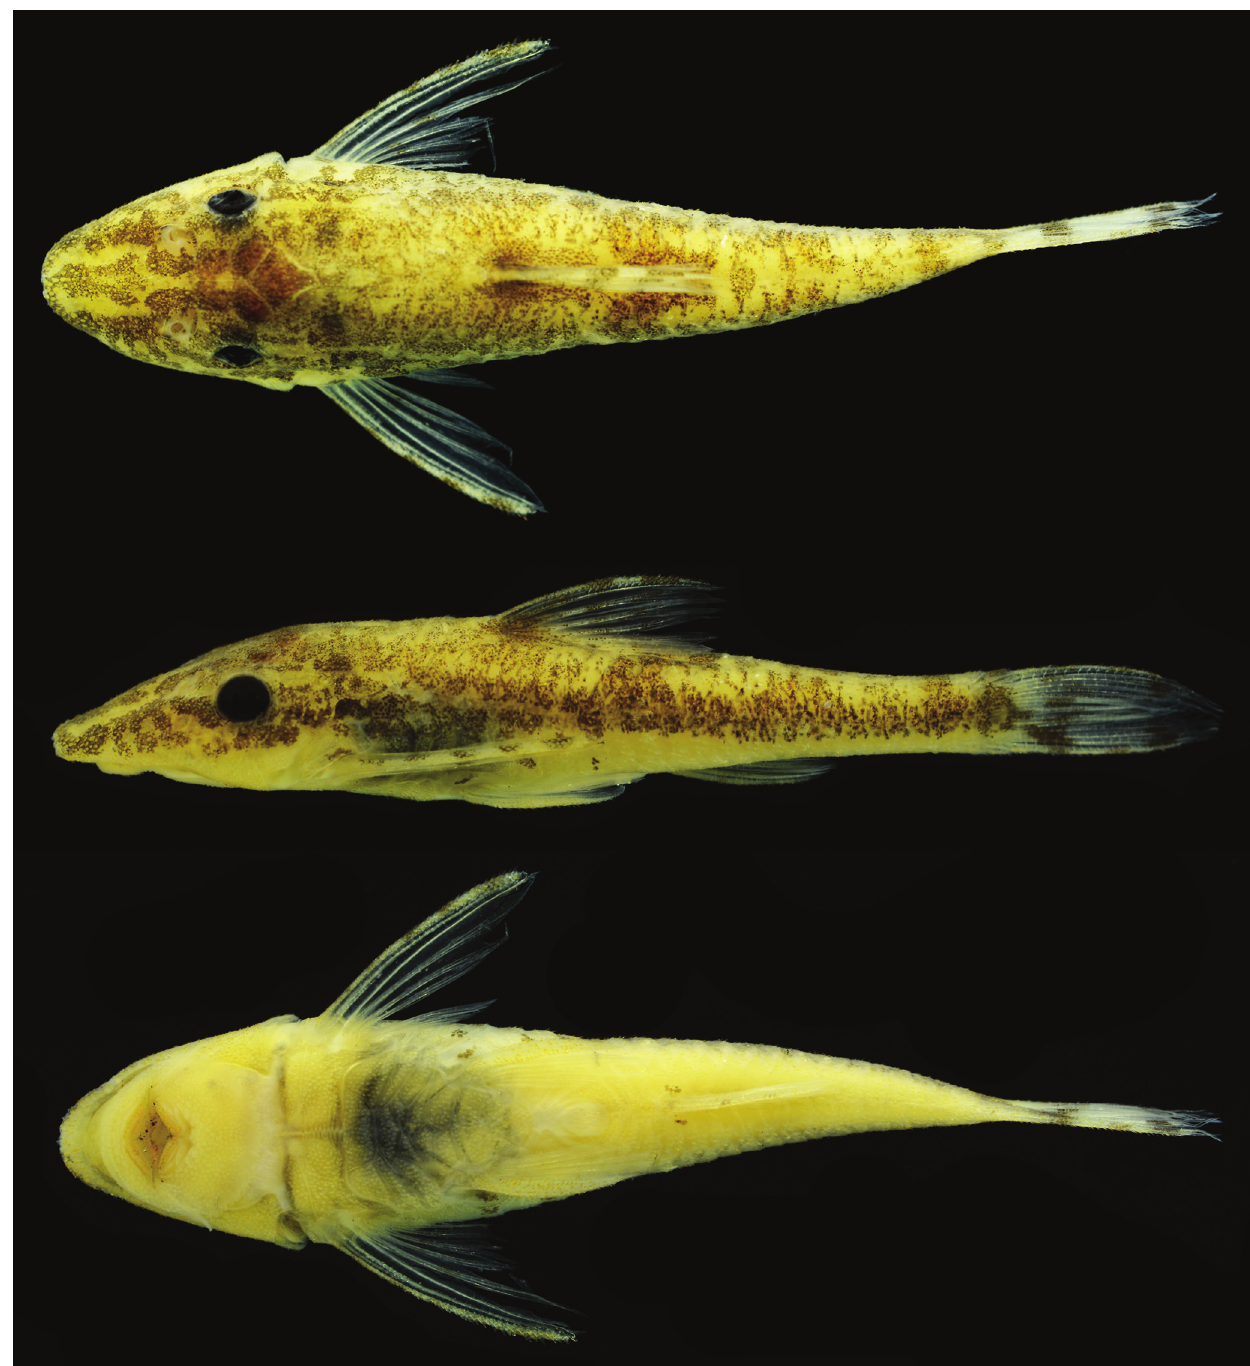
Fig. 1 . Curculionichthys hera , holotype, MCP 52500, female, 25.1 mm SL, igarapé do Onça, tributary to rio Curuá-Una on road BR-163 between Belterra and Rurópolis, Belterra, Pará,